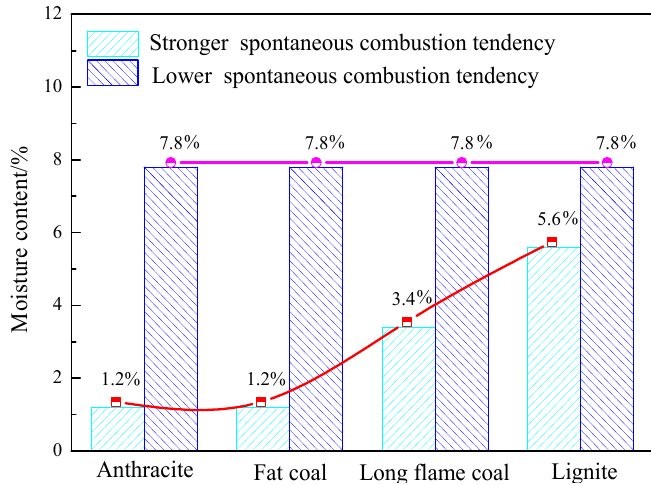
Figure 10. The curves of flammable moisture content and non-flammable moisture content for anthracite, fat coal, long flame coal, and lignite at four different low moisture